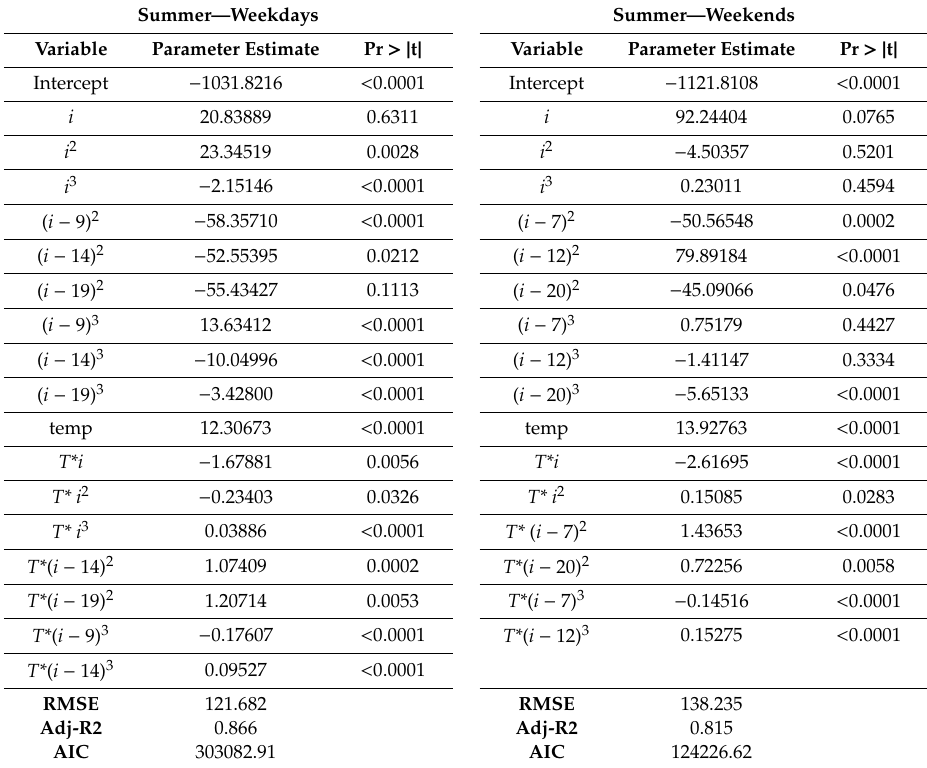
Table A4. The Results for the Regression Model for the Summer Season (Model 1).